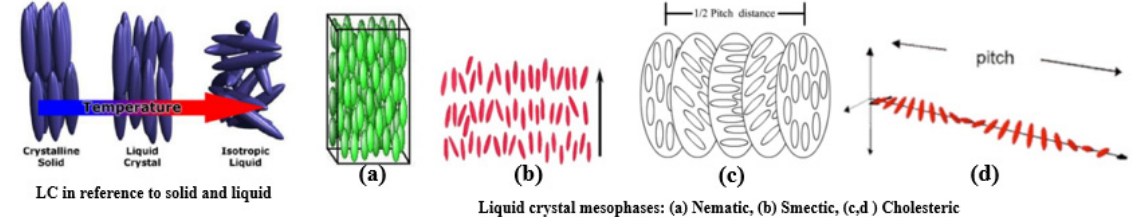
Figure 1. Liquid crystals in reference to crystalline solid and isotropic liquids (left), and the different mesophases of liquid crystals, (a) nematic, (b) smectic, (c) cholesteric, (d) cholesteric (different view) [10]. Figure from an open ‐ access article.